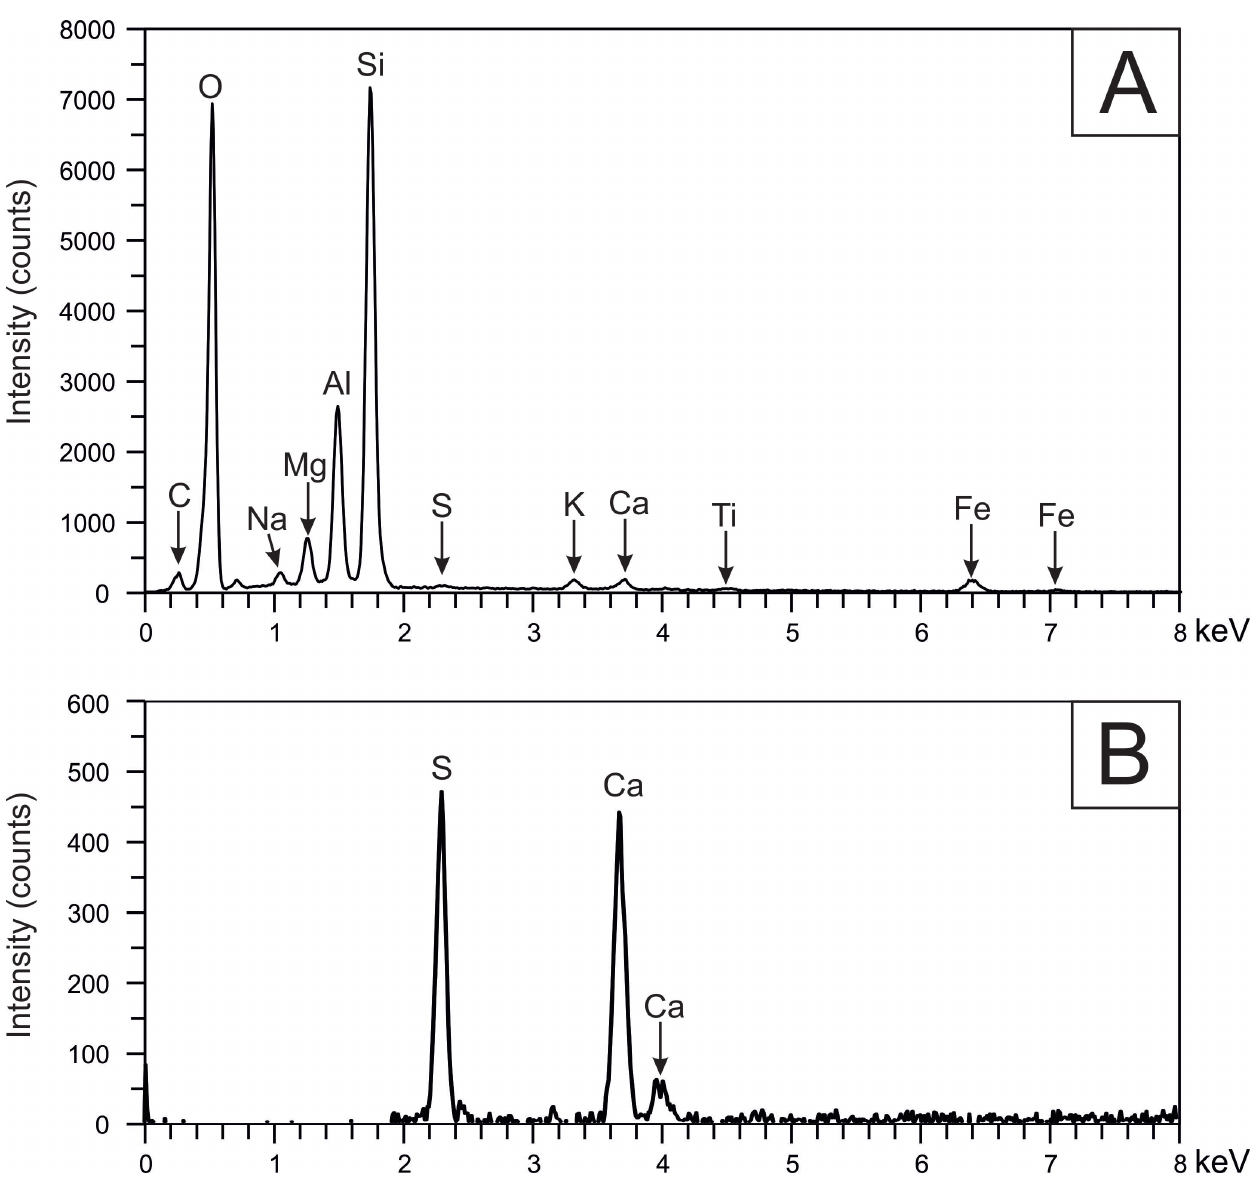
Figure 6. ( A ) Typical energy-dispersive X-ray microanalysis (EDXA) spectrum of the hydrous gel formed on the external surface of slice 1 piece AA. ( B ) Residual processed EDXA spectrum (after subtraction of background from the host gel matrix), indicative of calcium sulphate, recorded from the microcrystalline secondary phase that nucleated within the hydrous gel on the external surface of slice 1 piece